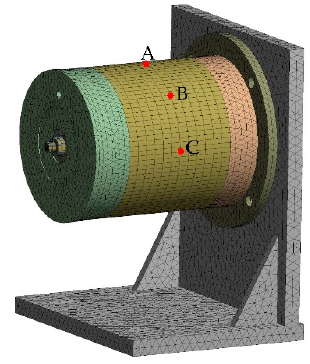
Figure 4. The 3-D PMSM harmonic response analysis model and the locations of the three measuring points on the casing.